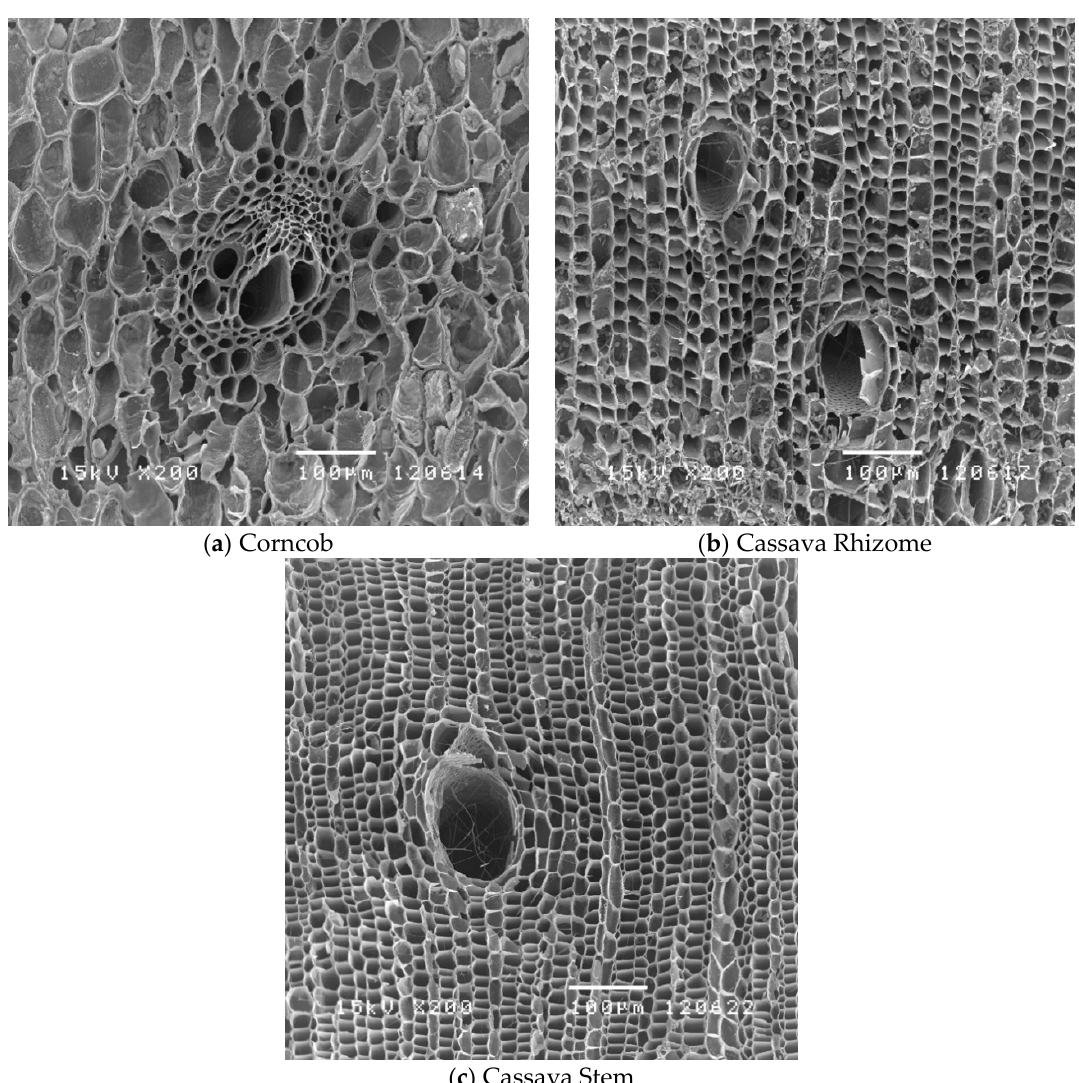
Figure 2. Scanning Electron Microscopy ( SEM) images showing differences in morphology of biochar produced from different biomass feedstocks.